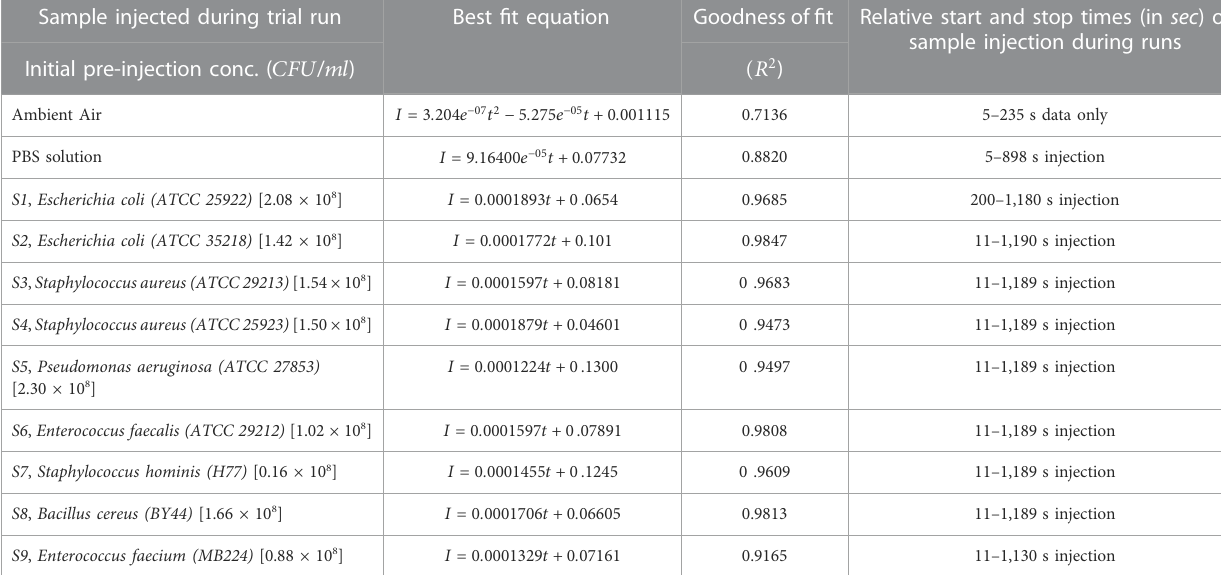
TABLE 3 Best fi t equations of the zero-initialized intensity (backscattered) observations of different samples (ambient, PBS solution, nine bacterial strains) with time (i.e., with varying concentrations). The pre-injection concentrations of species and their respective volumes are shown. Data pertain to the trials of 20 min duration runs. The start and stop of injection times (in seconds) of bioaerosol samples during different runs are indicated in the last column. Sample injected during trial